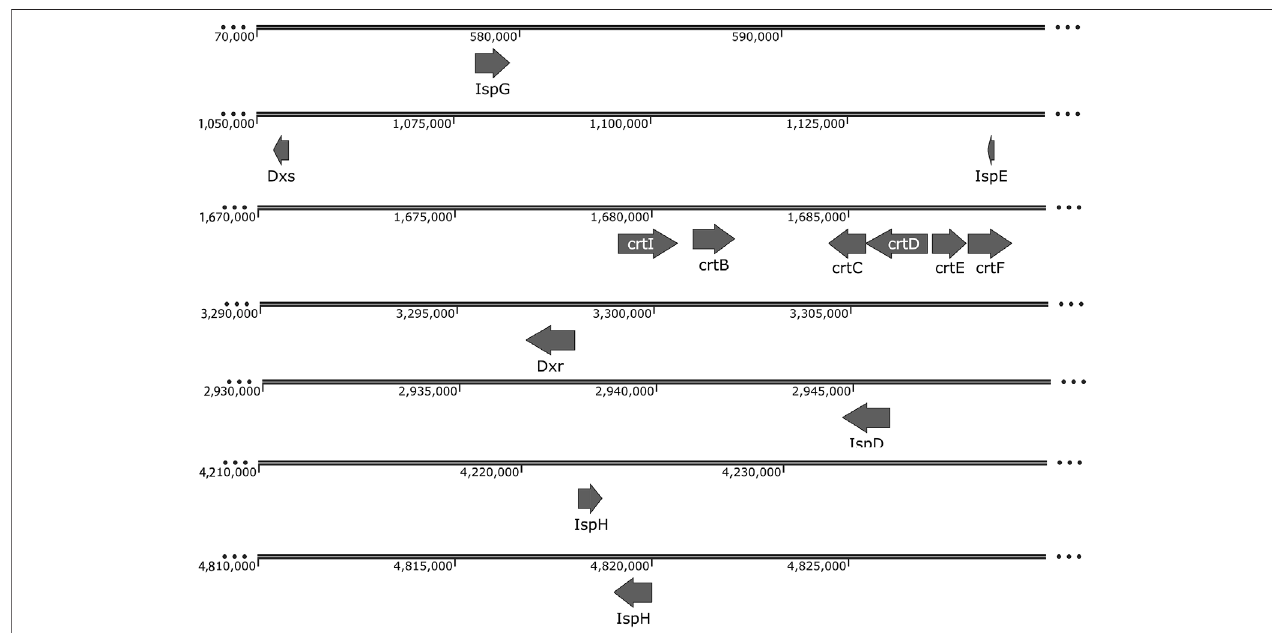
FIGURE 3 | Genome distribution of genes in the carotenoid synthetic pathway in R. palustris . Abbreviations: 1-deoxy-D-xylulose-5-phosphate synthase (DXS); 1- deoxy-D-xylulose 5-phosphate reductoisomerase (DXR); 2-C-methyl-D-erythritol 4-phosphate cytidylyltransferase (IspD); 4-diphosphocytidyl-2-C-methyl-D-erythritol kinase (IspE); 4-hydroxy-3-methylbut-2-enyl diphosphate synthase (IspG); 4-hydroxy-3-methylbut-2-enyl diphosphate reductase (IspH); amine oxidase/Phytoene desaturase (crtI), squalene/phytoene synthase (crtB), hydroxyneurosporene synthase (crtC), FAD dependent oxidoreductase (crtD), polyprenyl synthetase (crtE), O-methyltransferase family 2